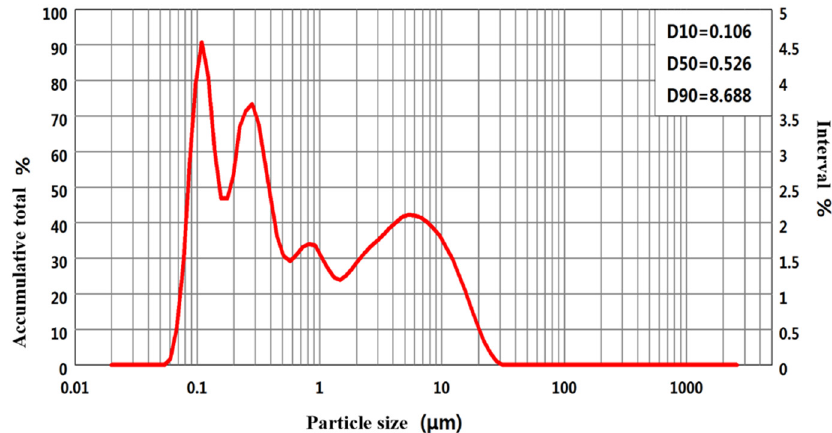
Figure 1: Particle size distribution of nano - ZrSi 2 particles.